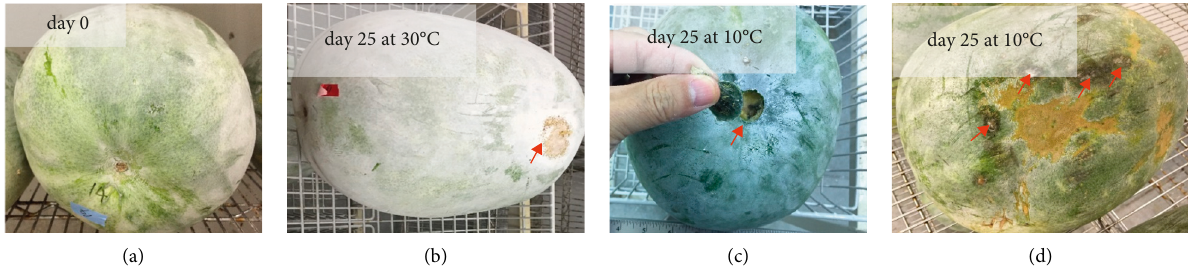
Figure 3: Appearance of winter melon fruit stored under different conditions (a) day 0; (b) day 25 at 30 ° C; (c) and (d) day 25 at 10 ° C. Red arrows indicate the dry rot spot, stem scaring, and water-soaked spots/soft rot spots,